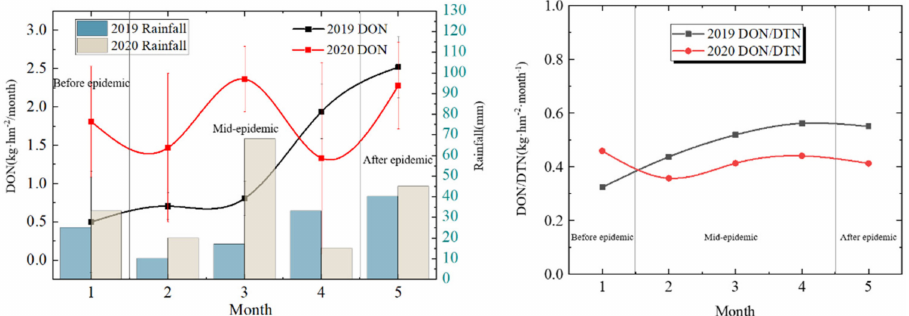
Figure 4. DON around COVID-19